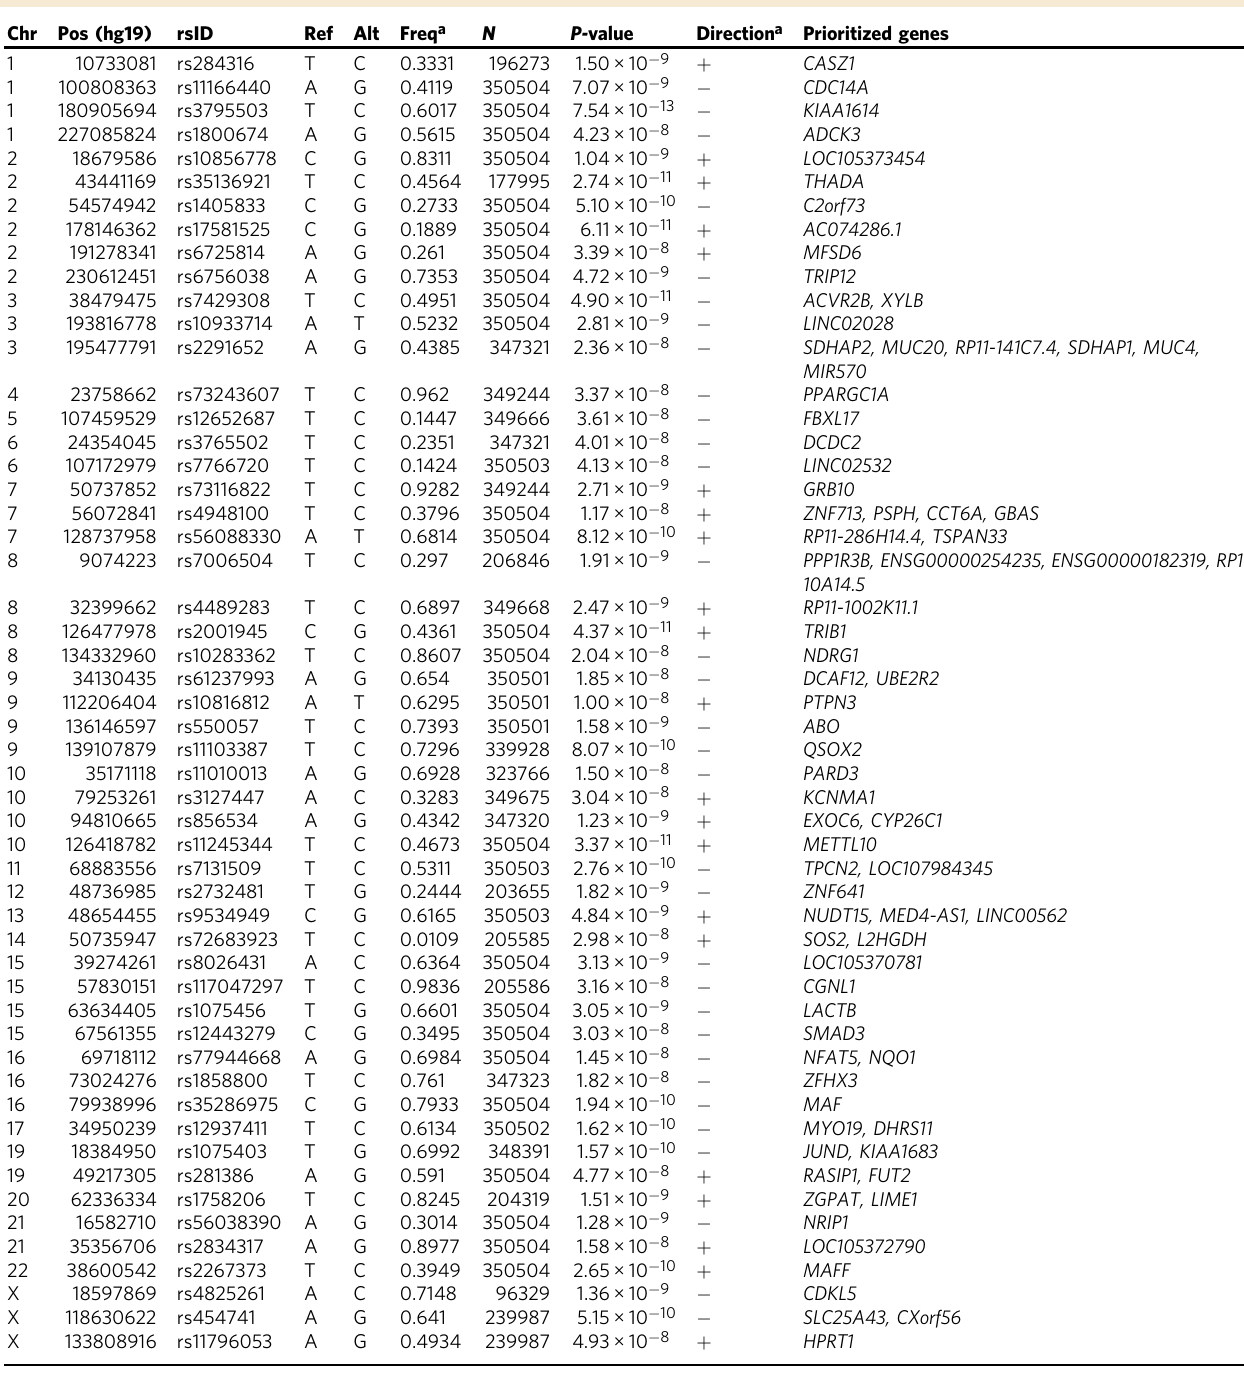
Table 1 Lead variants for novel eGFR loci from meta-analysis Chr Pos